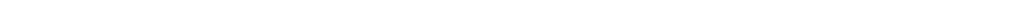
(see fi gure on previous page) Fig. 4 Combined GSK3 β and PARP inhibition increases DNA damage and mitotic aberrancies. A Western blot analysis of indicated proteins in HCT-15 cells (parent) or corresponding GSK3 β -depleted single clone (KO1 and KO2) cells treated with 5 μ M simmiparib (SP) for 48 h. B Western blot analysis of indicates proteins in HCT-15 cells treated with 5 μ M simmiparib, GSK3i (10 μ M CHIR99021 HCl or 5 μ M LY2090314), or a combination for 48 h. SP, simmiparib; CHIR, CHIR99021 HCl; LY, LY2090314. C and D Representative images of p-RPA32 (S33) and γ -H2AX foci in HCT-15 (parent) and their GSK3 β -depleted single clone (KO1 and KO2) cells treated with 5 μ M simmiparib ( C ) or HCT-15 cells following treatment with 5 μ M simmiparib, GSK3i (5 μ M LY2090314), or a combination for 48 h ( D ). Nuclei were stained with DAPI. Scale bar: 2 μ m. Cells that contained fi ve or more p-RPA32 or γ -H2AX foci/nucleus were considered as positive cells. At least 50 cells were analyzed for each experiment and condition. All data are expressed as mean ± SD from three independent experiments. ( C : *** p < 0.001, t test; D : *** p < 0.001, one-way ANOVA). SP, simmiparib; CHIR, CHIR99021 HCl; LY, LY2090314. E The combination of GSK3i and PARPi increases anaphase bridge-positive cells. HCT-15 cells were treated with 5 μ M simmiparib (SP), 5 μ M LY2090314 (LY), or a combination for 48 h. Cells were examined by DAPI-staining and microscopy for chromatin bridges. Representative images (upper panel; scale bar: 2 μ m) and percentages of anaphase bridge-positive cells are shown (lower panel; * p < 0.05, ** p < 0.01, one-way ANOVA). Anaphase cells (Control: 45 cells; SP: 44 cells; LY: 47 cells; SP + LY: 52 cells) from fi ve independent experiments. Data are expressed as mean ± stand error of mean (SEM). F The combination of GSK3i and PARPi impairs mitotic spindles. HCT-15 cells were immunostained with α -tubulin (green) for mitotic spindles and pericentrin (red) for centrosomes after treated with 5 μ M simmiparib (SP), 5 μ M LY2090314 (LY), or a combination for 48 h. Nuclei were stained with DAPI. Representative images (upper panel; scale bar: 2 μ m) and percentages of abnormal spindles are shown (lower panel; *** p < 0.001, one-way ANOVA). At least 50 cells were analyzed for each experiment and condition. Data are expressed as mean ± SD from three independent